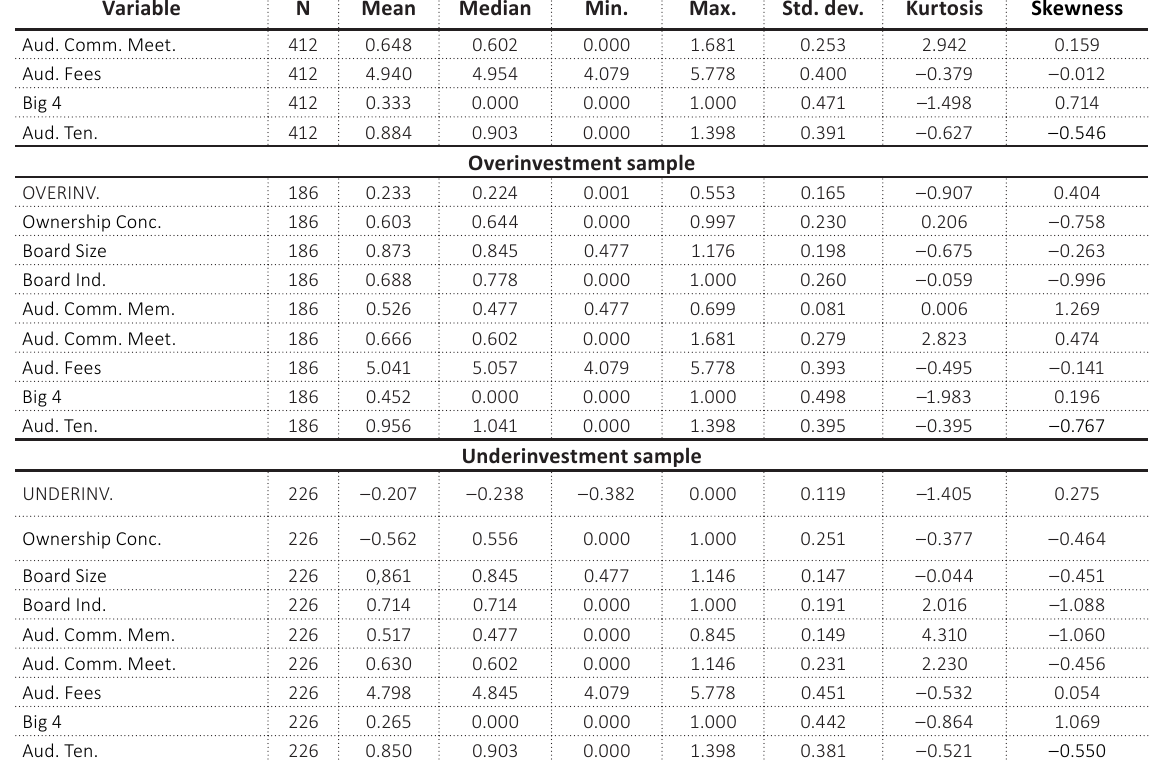
Table 1 (cont.). Descriptive statistics of the